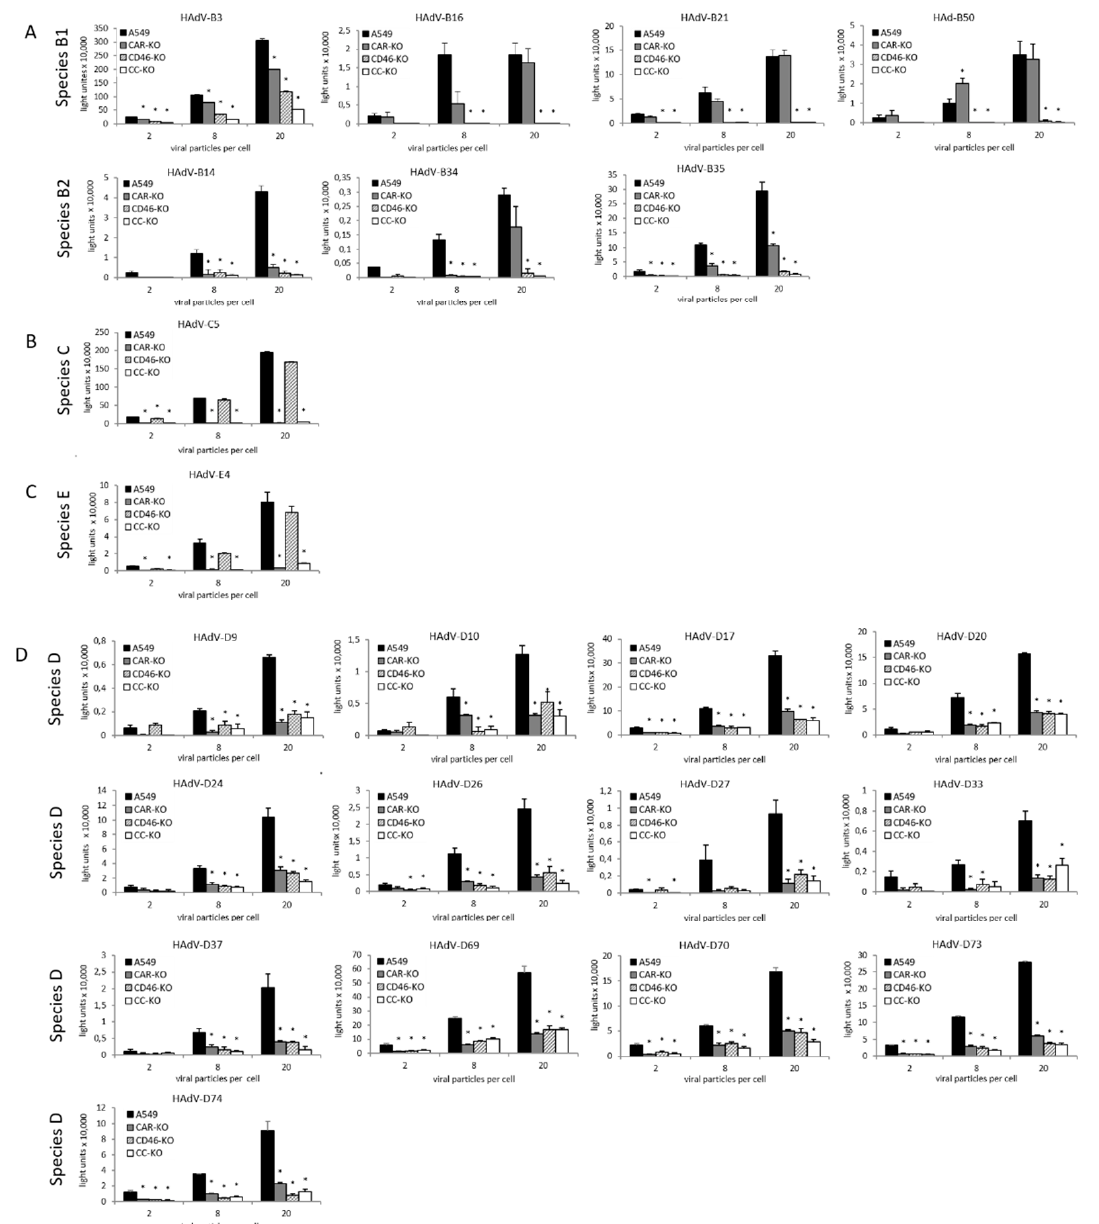
Figure 6. Screening of receptor usage in adenovirus species B, C and E adenoviruses. Parental A549, CAR-KO, CD46-KO and CC-KO cells were transduced with respective viruses at varying viral particle numbers per cell (VP/C: 2, 8, 20). Luminescence levels were analyzed 26 h post-infection. Uninfected cells were used for the background level. Each bar represents the mean of triplicated wells (96-well plate). Error bars represent standard deviation. Each of the KO cell lines was compared to the A549 cell line. Significant luminescence reductions are marked by * ( p < 0.05). Each graph represents data from one out of three independent experiments. All experiments are depicted in Supplementary Figure